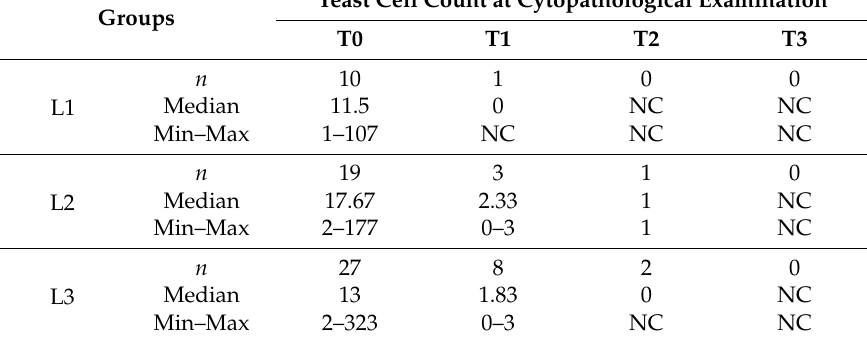
Table 4. Assessment of fungal burden at the cytopathological examination according to the distribution of lesions in cats with sporotrichosis over the treatment with itraconazole and potassium iodide, Lapclin- Dermzoo/INI/Fiocruz